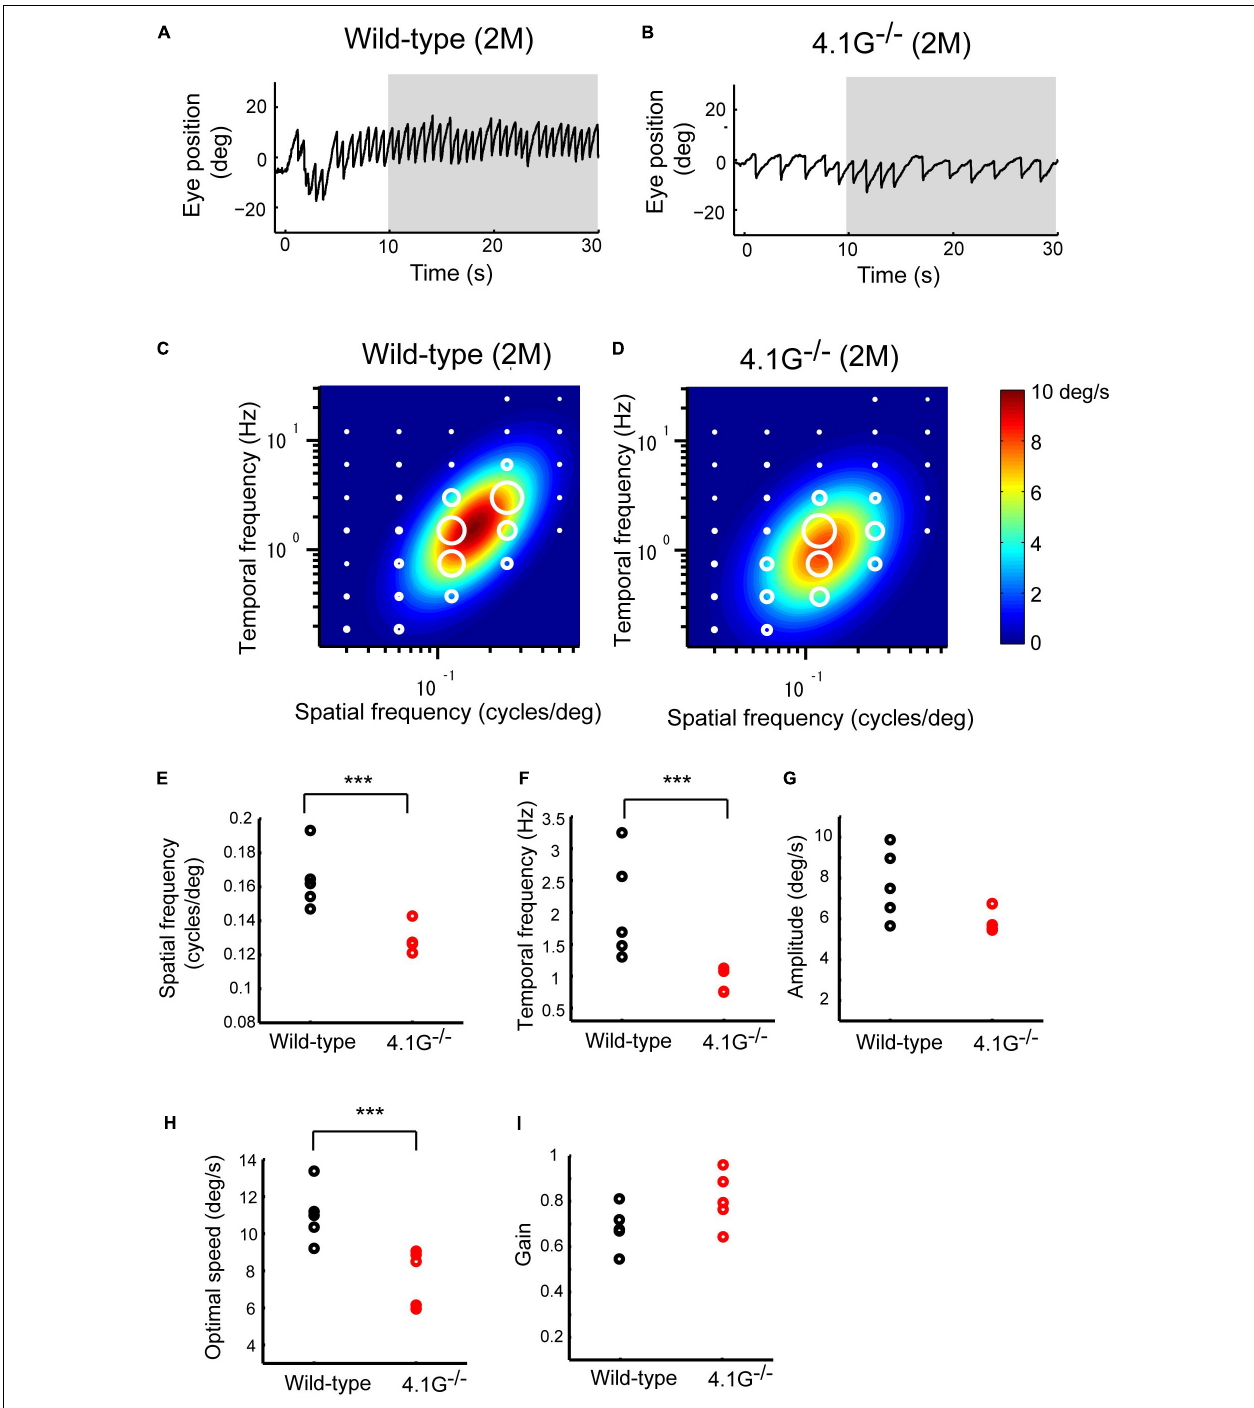
FIGURE 9 | Late OKRs in the young adult 4.1G - / - mice. (A,B) Eye position profiles during OKNs in wild-type control mouse (A) and in 4.1G - / - mouse. (B) . Mice were exposed against a moving sinusoidal grating patterns (T-N direction spatial frequency 0.125 cycles/deg, temporal frequency 1.5 Hz, contrast 64%) for 30 s. Slow phase eye velocities during 20-s intervals starting 10 s after the onset of visual motion averaged for each stimulus condition (gray shaded area). (C) Heat maps of the late-phase OKRs in young adult wild-type control mice (2–3 months old, n = 5) and (D) young adult 4.1G - / - mice (2–3 months old, n = 5). Mean amplitudes of the slow-phase eye velocity of the late OKRs represented by diameter of the white circles are plotted in the coordinate system of SF and TF. Heat maps indicate the best-fit Gaussian functions (C,D) . Comparisons of the properties of the late-phase OKRs. The differences in the optimal SF (E) , optimal TF (F) , peak amplitude of the responses (G) , stimulus speed at the optimal spatiotemporal frequency (H) , and gain at optimal stimuli (I) are shown individual plots (black dots: wild-type, red dots: 4.1G - / - ). *** p = 7.9 × 10 - 3 , Wilcoxon rank-sum test.